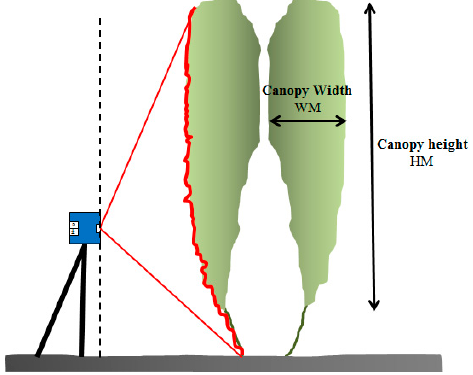
Figure 2. Measured parameters for the manual canopy characterization and LiDAR scanner location.